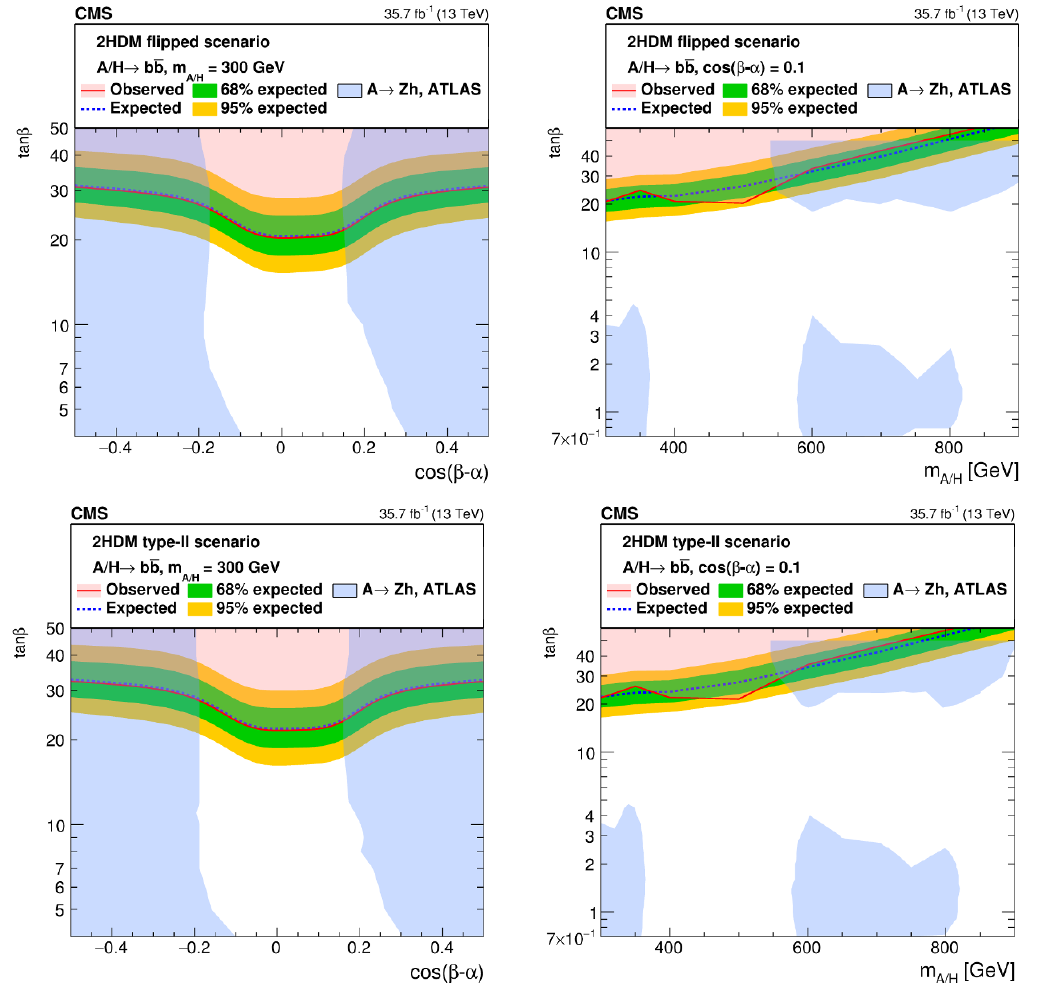
Figure 8 . Upper limits for the parameter tan (cid:12) at 95% CL for the (cid:13)ipped (upper) and type-II (lower) models, as a function of cos( (cid:12) (cid:0) (cid:11) ) in the range of [ (cid:0) 0 : 5 ; 0 : 5] for the mass m H = m A = 300 GeV (left) and as a function of m A = H when cos( (cid:12) (cid:0) (cid:11) ) = 0 : 1 (right). The observed limits from the ATLAS A ! Zh analysis [24] at 95% CL, which are provided up to tan (cid:12) = 50, are also shown as blue shaded area for